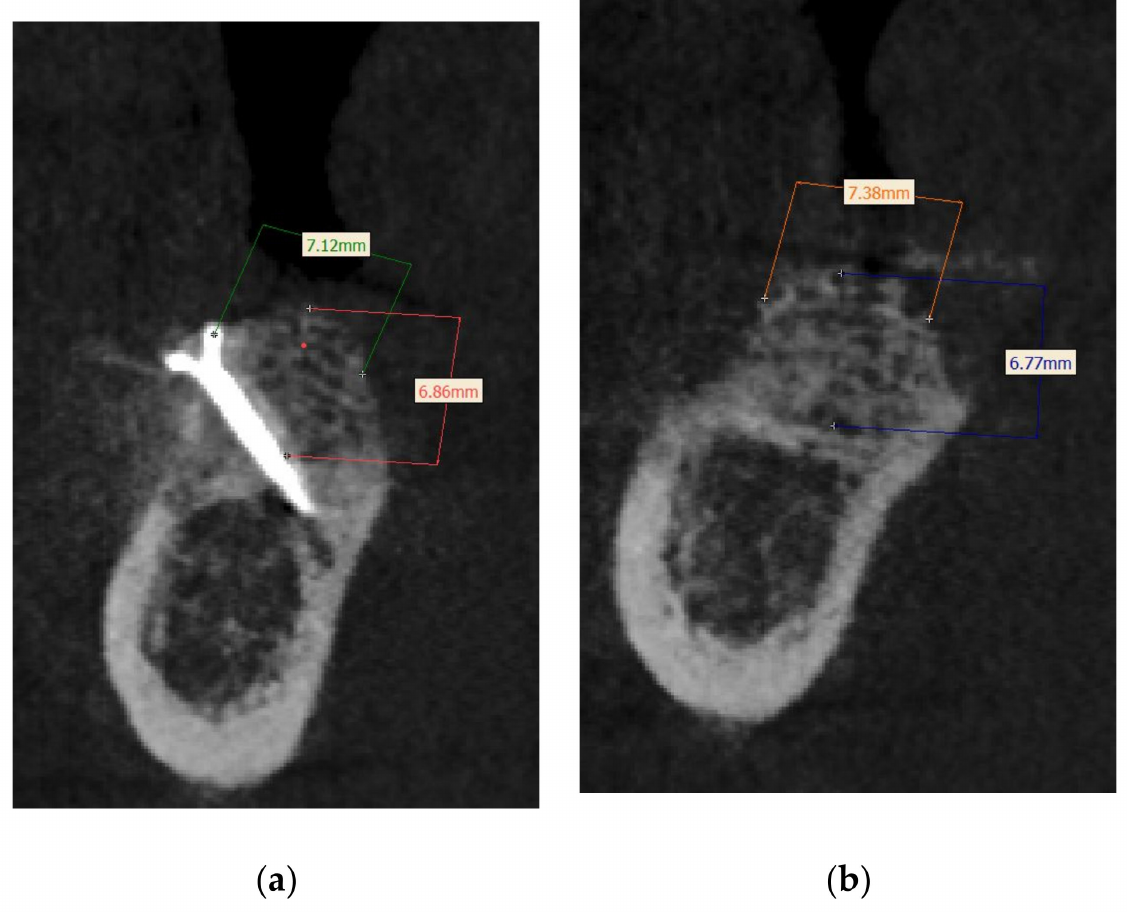
Figure 12. ( a , b ) The results in bone gain in width and height.